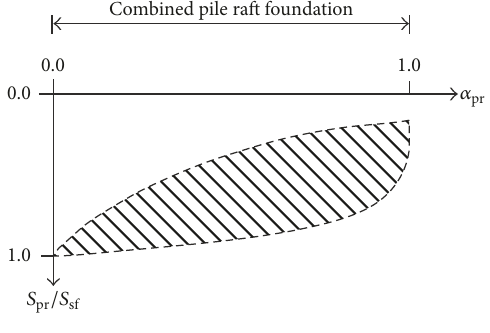
Figure 1: Settlement of a